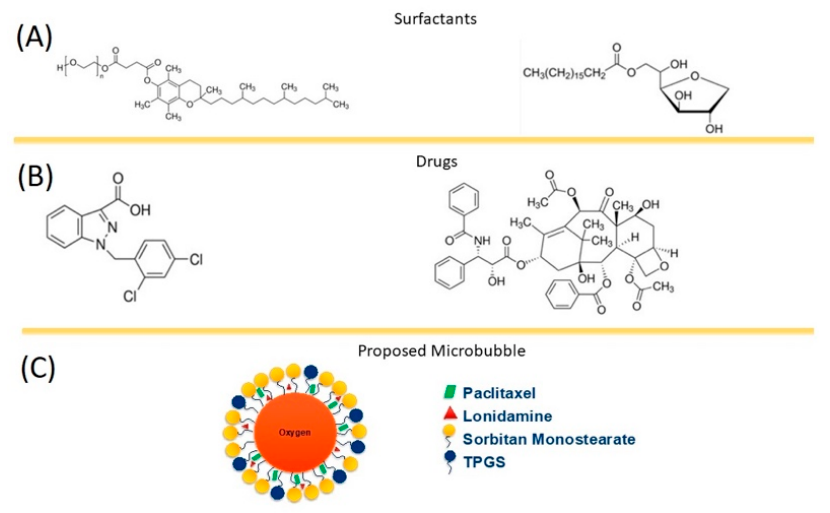
Figure 1. Microbubble shell component. ( A ) Surfactants, ( B ) Drugs, ( C ) Proposed model.